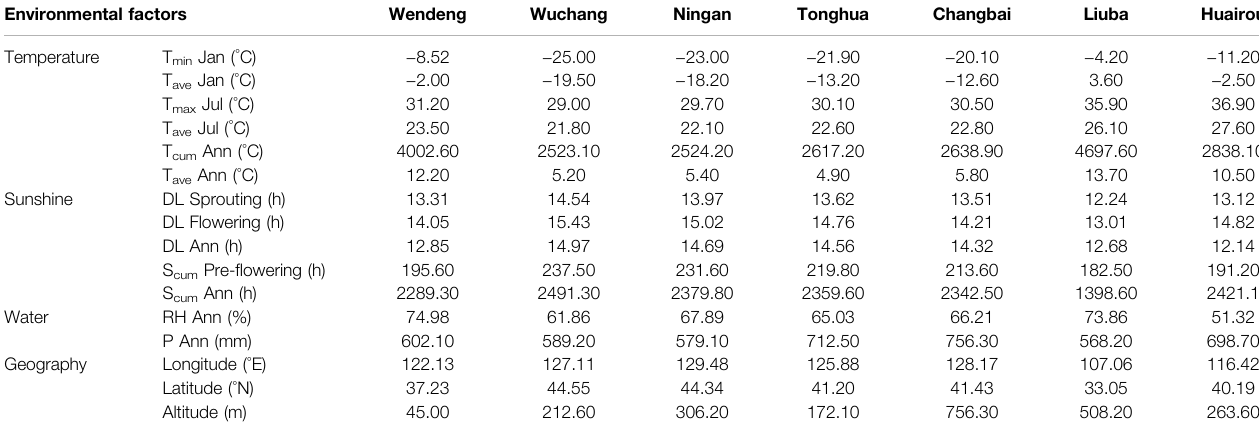
TABLE 1 | Overall comparison of environmental factors among seven cultivated locations of American ginseng from 2017 to 2019 in China. Environmental factors Temperature